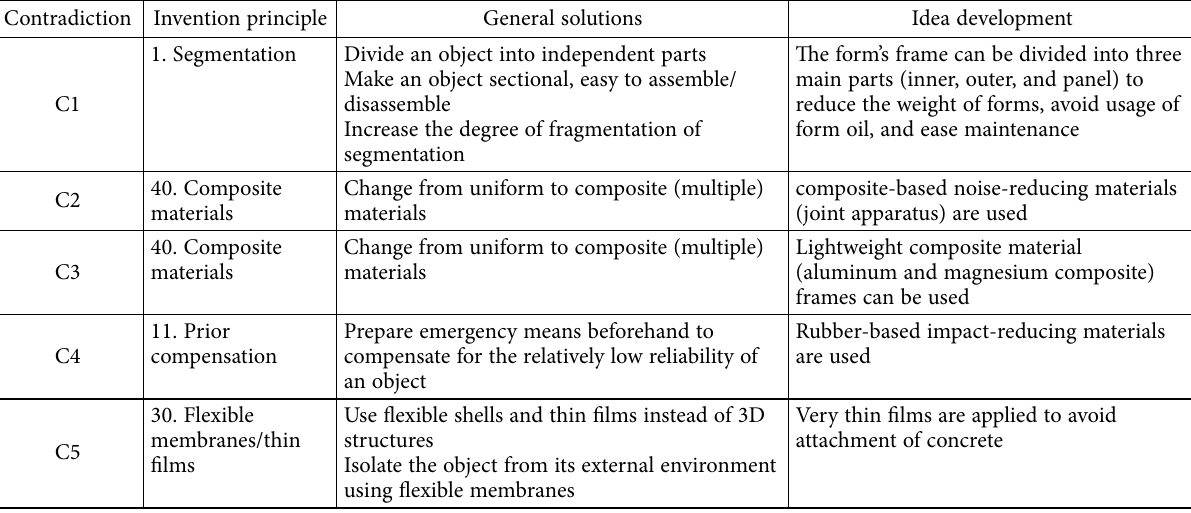
Table 8. Idea development based on general solutions of TRIZ